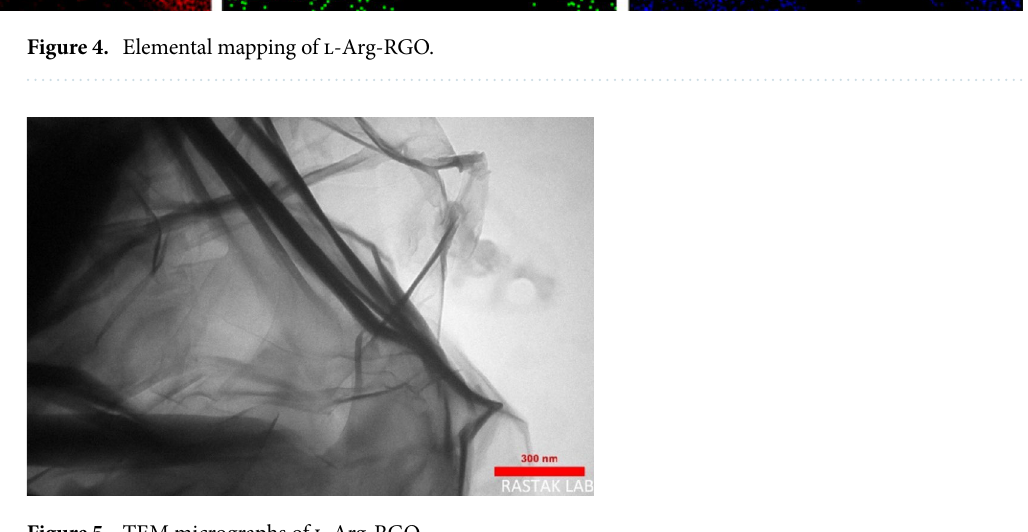
Figure 5. TEM micrographs of